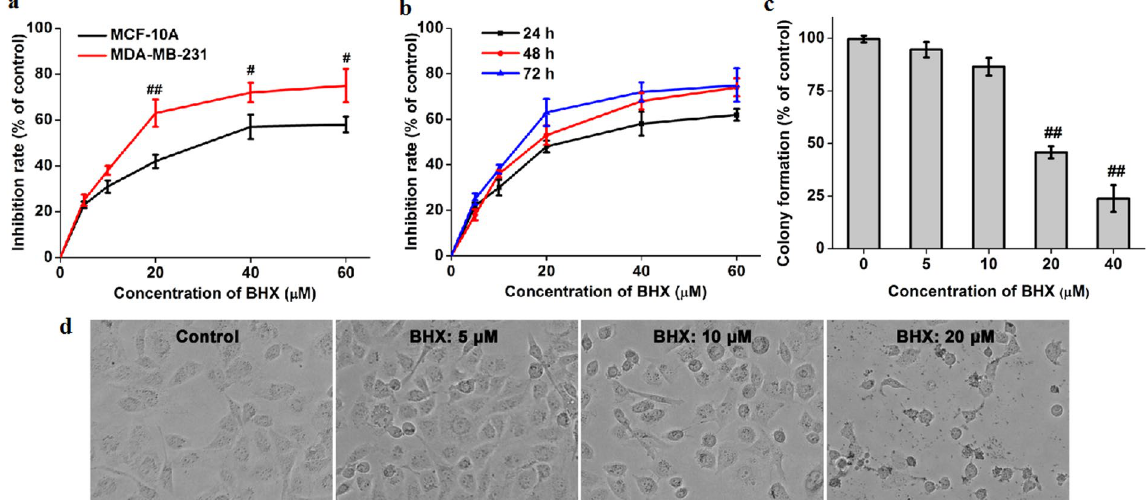
Figure 2. Effect of BHX on cell viability of MDA-MB-231 cells. ( a ) MCF-10A and MDA-MB-231 cells were treated with different concentrations of BHX for 72 h. ( b ) Cell viability was decreased in MDA-MB-231 cells at the indicated time points. (c) BHX suppresses colony formation of MDA-MB-231 cells. Results are expressed as means ± S.D. from three independent experiments. # p < 0.05 and ## p < 0.01. (d) Morphological changes of MDA-MB-231 cells 24 h after incubation with BHX (200 × ). Black arrows indicate cell shrinkage and cell fragmentation.